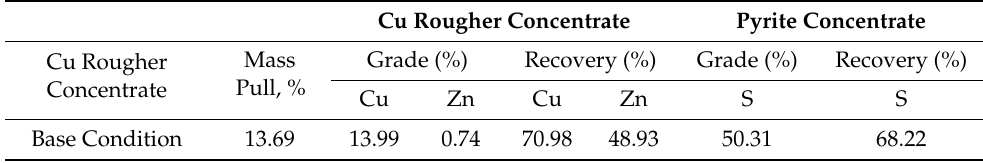
Table 6. Flotation behavior of Ore A under the Base Condition.